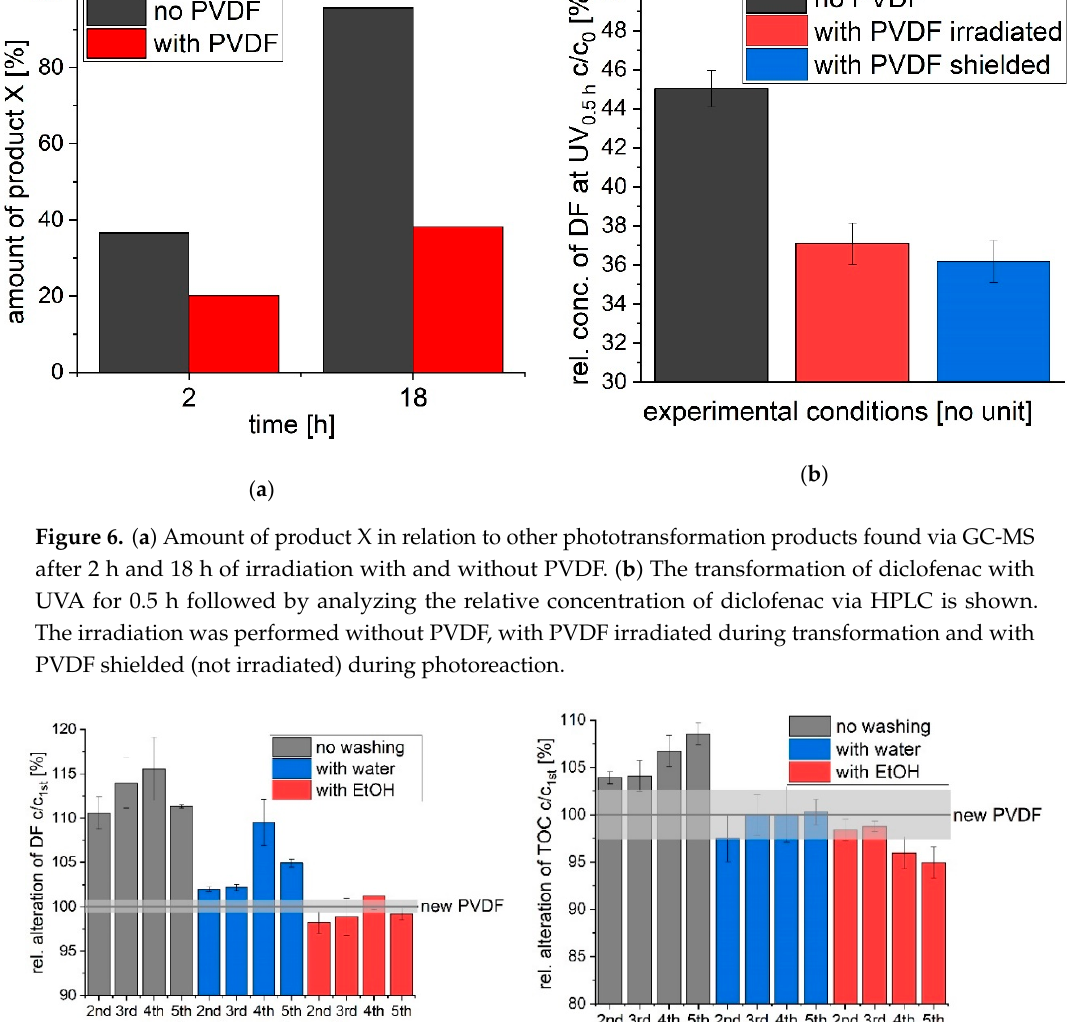
Figure 5. ( a ) Absorbance spectrum of non-irradiated and 30 min UVA irradiated diclofenac with and